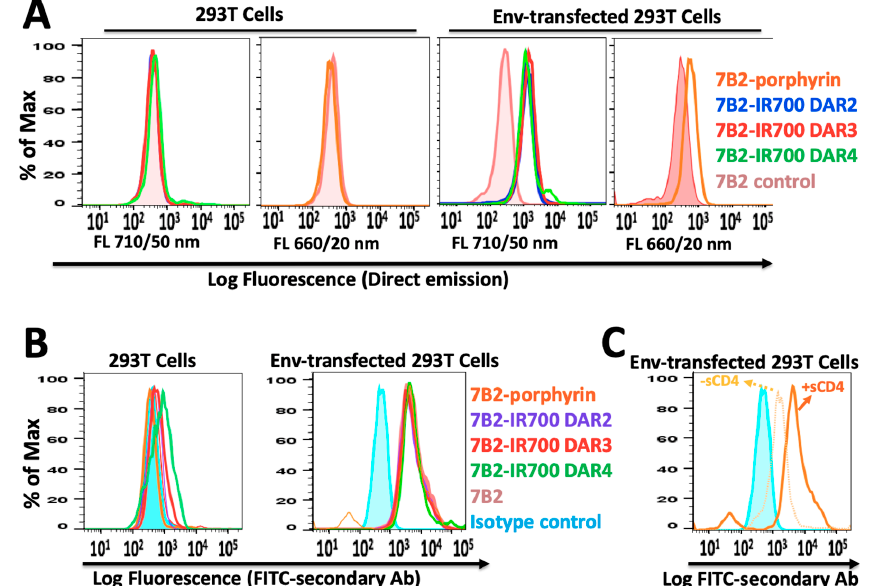
Figure 3. The flow cytometry histogram of PICs by using 293T control cells and Env-transfected 293T cells incubated in PBS + 1% BSA + sodium azide (0.2%). ( A ) PIC binding to 293T cells transfected with 92UG037.8 gp160 (293T/92UG) cells was directly detected through red fluorescent emission from IR700-PICs and porphyrin-PIC, by filter Qdot 705 and filter Qdot 655, respectively. ( B ) By using FITC-secondary immunofluorescence, PICs showed equal binding ability into Env-transfected cells, while 7B2-IR700 DAR4 showed somewhat unspecific binding into the control 293T cells. Results are representative of at least three independent experiments. Isotype control (chimeric RAC18) is shown as blue shaded histogram. ( C ) Studying the binding ability of porphyrin-7B2, in the presence and absence of soluble CD4